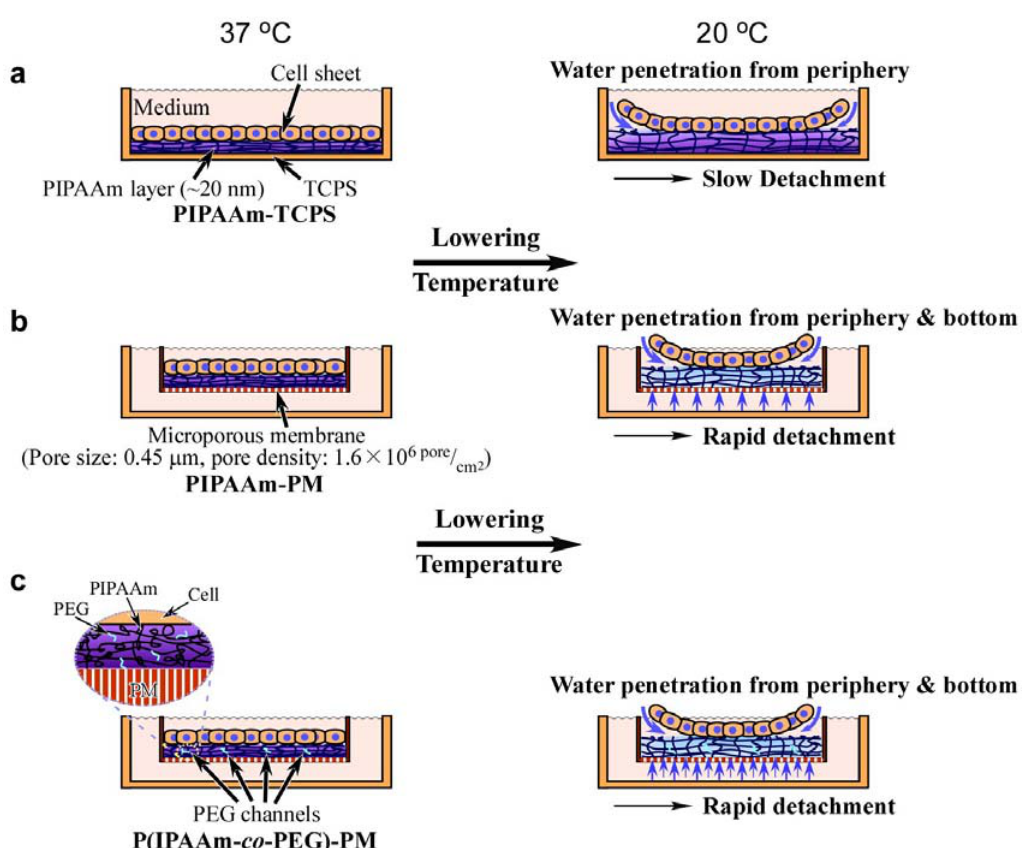
Figure 4. Schematic illustration of cell sheet detachment with varying water supply: ( a ) PIPAAm gel modified tissue culture polystyrene surface (PIPAAm-TCPS); ( b ) PIPAAm grafted porous membrane (PM) (PIPAAm-PM); and ( c ) PIPAAm co -grafted with poly(ethylene glycol) (P(IPAAm- co -PEG)) grafted PM (P(IPAAm- co